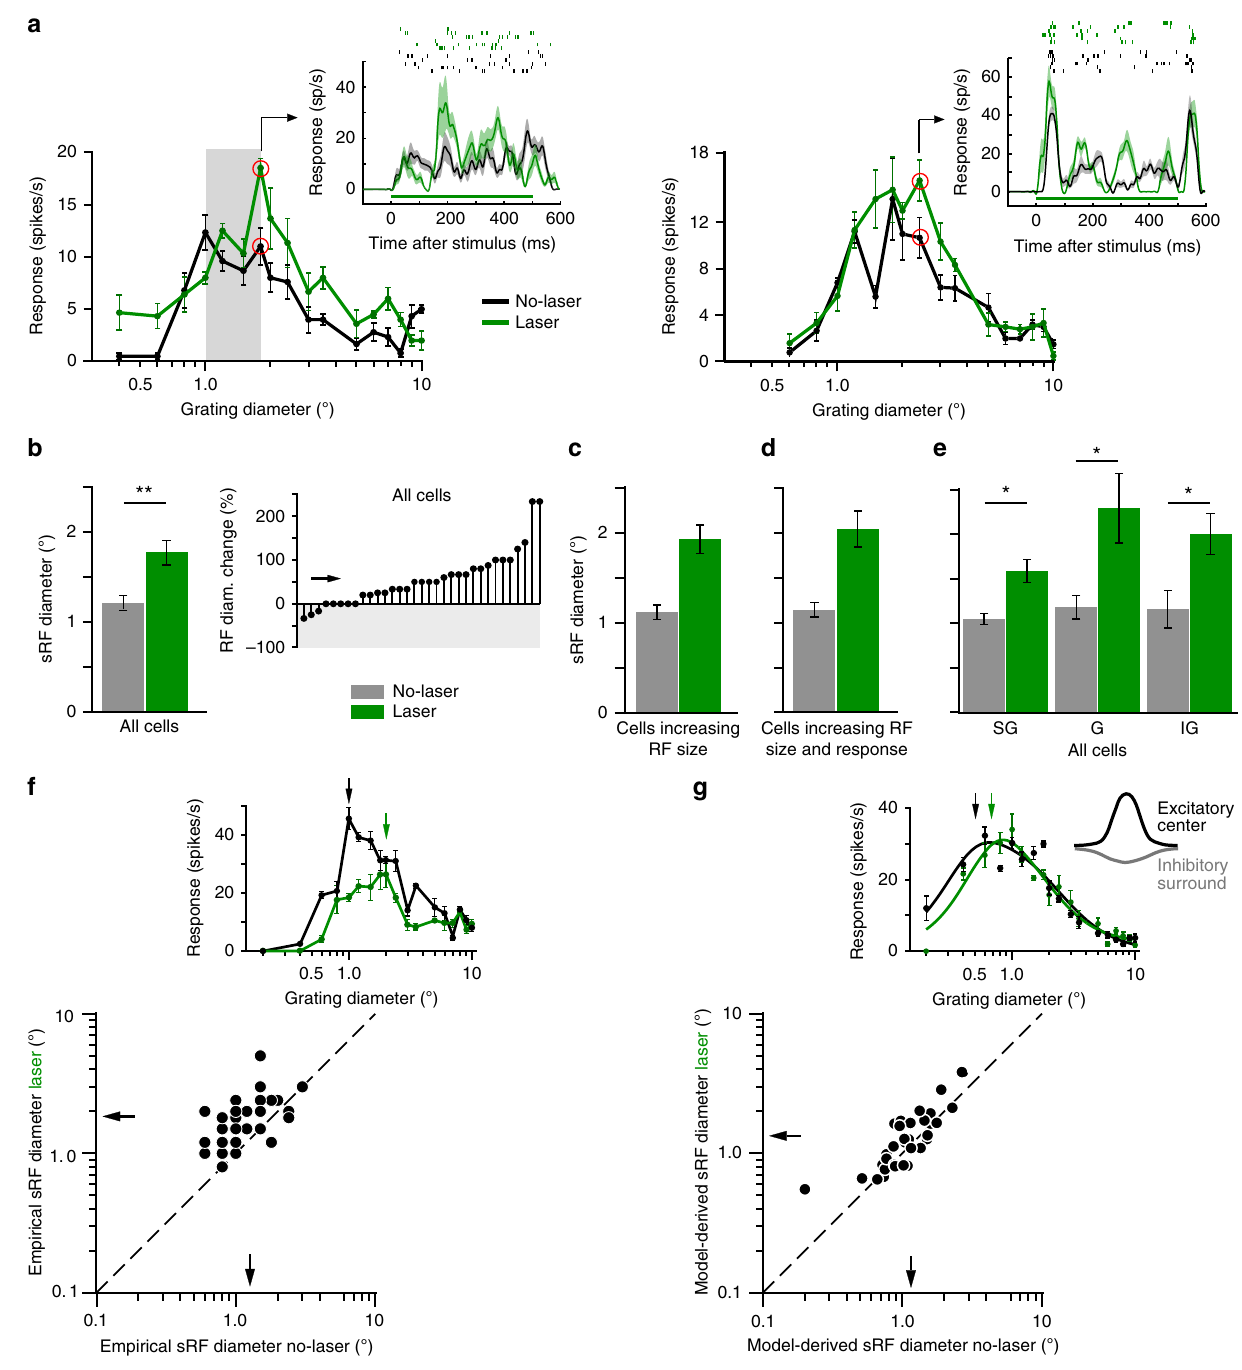
Fig. 2 V2 feedback controls RF size. a Spatial summation curves for two example V1 cells recorded with (green) and without (black) laser stimulation. Gray area in left panel: proximal surround. Insets: PSTHs (Bottom; due to the smoothing fi lter used, response onset starts at time zero) and raster plots (Top) measured at the stimulus diameters indicated by the red circles in the respective size-tuning curves. Green horizontal line: laser-on time. Two additional example cells are shown in the insets of panels f and g . b – e Mean sRF size (diameter at peak response of empirically measured spatial summation curve) with and without laser stimulation for: b All cells (LEFT; n = 33); RIGHT: Cell-by-cell percent change in sRF size across the entire cell population. Downward and upward stem: decreased and increased sRF size, respectively . Arrow: mean. c Only cells showing increased sRF size with laser stimulation ( n = 25; mean sRF diameter ± s.e.m. no laser vs. laser: 1.12 ± 0.08° vs. 1.93 ± 0.08°). d Only cells showing both increased sRF size and peak response with laser stimulation ( n = 12; 1.14 ± 0.08° vs. 2.04 ± 0.20°). e Mean sRF size for all cells (as in b ), but grouped according to layer. SG: supragranular; G: granular; IG: infra-granular. f – g Scatterplots of sRF diameter with and without laser stimulation for sRF diameter derived directly from the empirically measured summation curves ( f ), or from the model curves fi tted to the summation data ( g ), as indicated in the insets above each scatterplot. Insets in f and g show the size tuning curve of two additional example cells. The summation data for the cell in g are fi tted with the ROG model. Arrows in insets in f and g indicate the sRF diameters. Arrows in scatterplots: means. Dashed line in f – g : unity line. Here and in all remaining fi gures error bars are